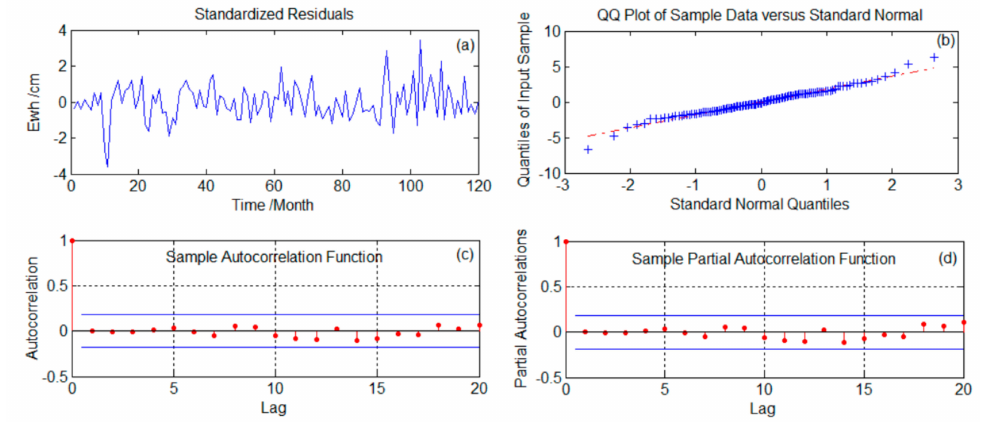
Figure 6. Test results of the ARMA model established in this